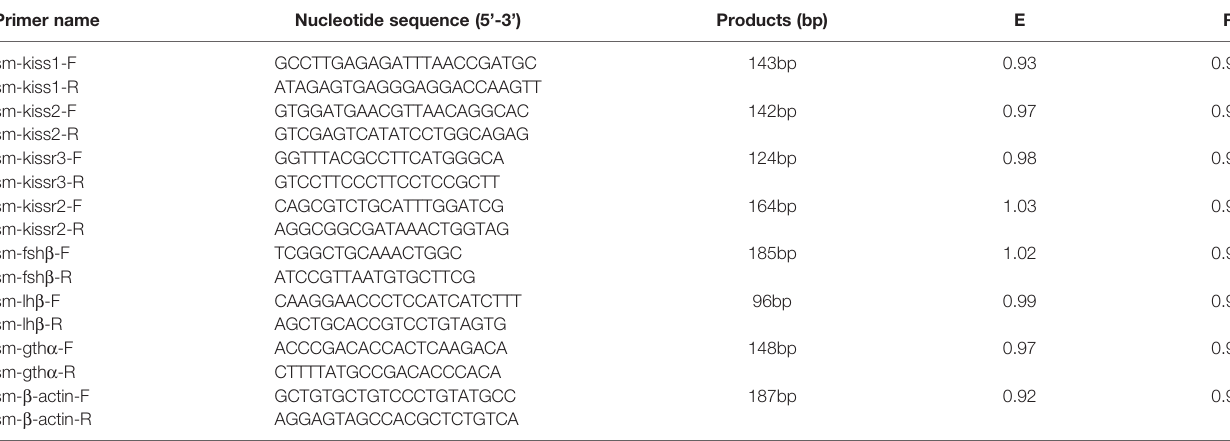
TABLE 2 | List of primers used for qPCR expressions analysis of kiss and kissr